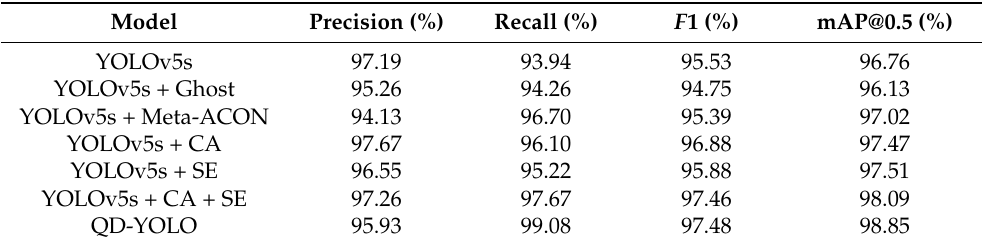
Table 3. Comparison of performance-optimization effects of different attention